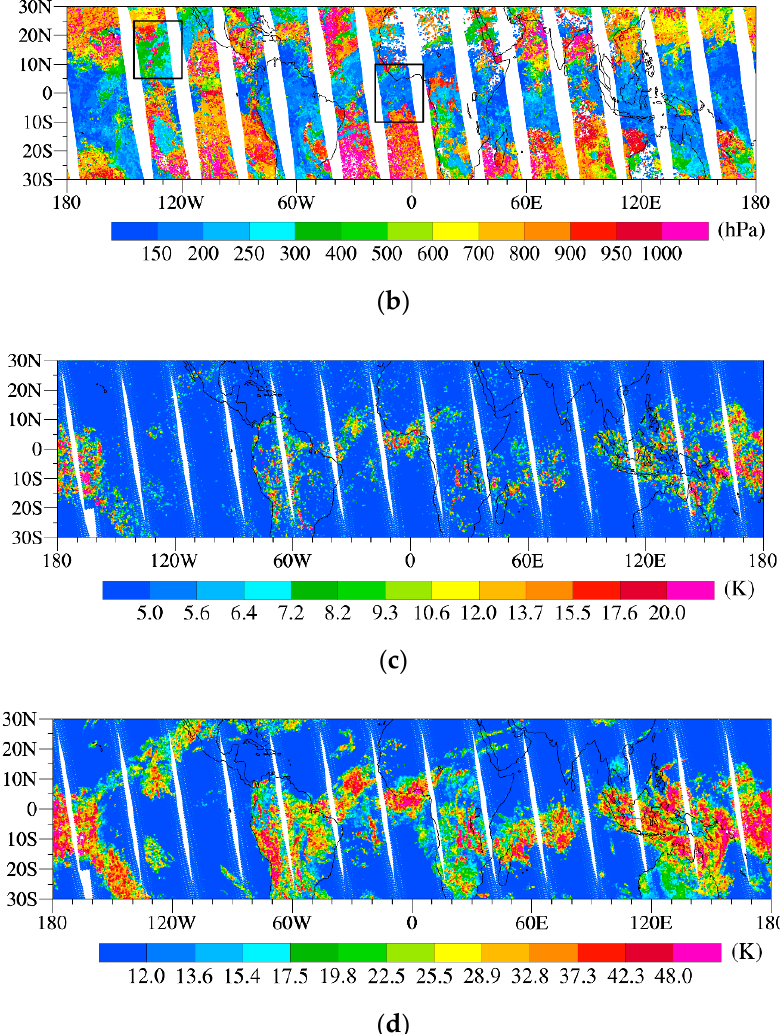
Figure 12. Spatial distributions of ( a ) AIRS ice cloud optical depth (color interval for ln(optical depth) is 0.3), ( b ) AIRS cloud-top pressure, ( c ) CESI MM -6 (~321 hPa) and ( d ) CESI MM -26 (~765 hPa) at ascending nodes on 2 February 2019. Color interval for ln(CESI) is 0.126.